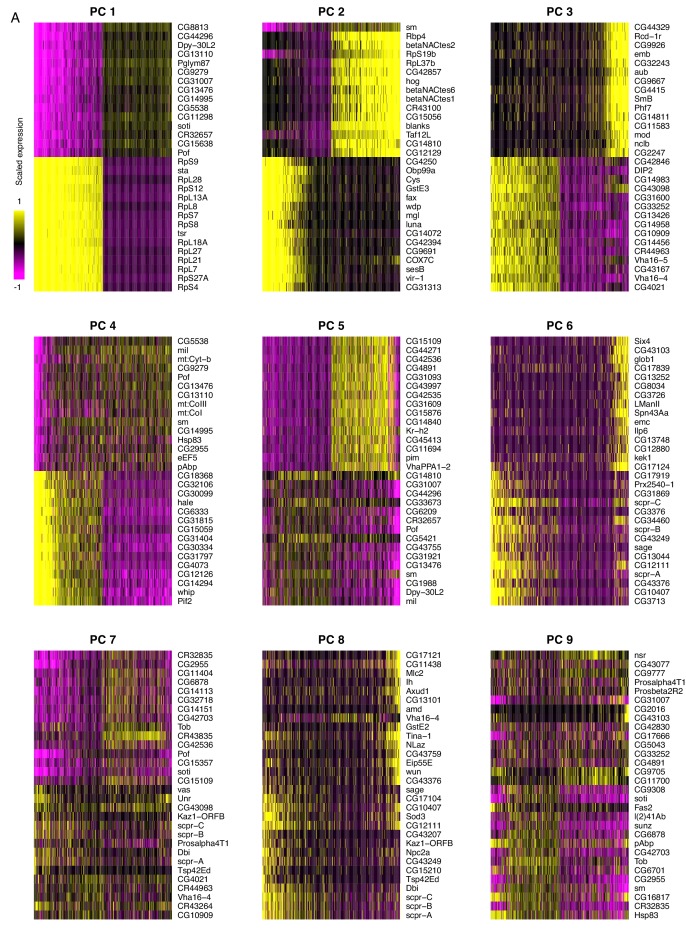
Principal component analysis of testis-expressed genes.Horizontally, each line is 500 randomly selected cells, and vertically, the expression of the 15 genes with the highest positive and negative scores for the principal component. For PC 1, one interpretation could be that soti, a marker of late spermatocytes/early spermatids, is negatively correlated with the expression of many ribosomal protein genes. This is consistent with our finding that ribosomal protein genes peak in early spermatogenesis. It is worth noting that the higher numbered PCs become more and more diffuse, as they each explain a smaller proportion of variance than the PCs 1 and 2.